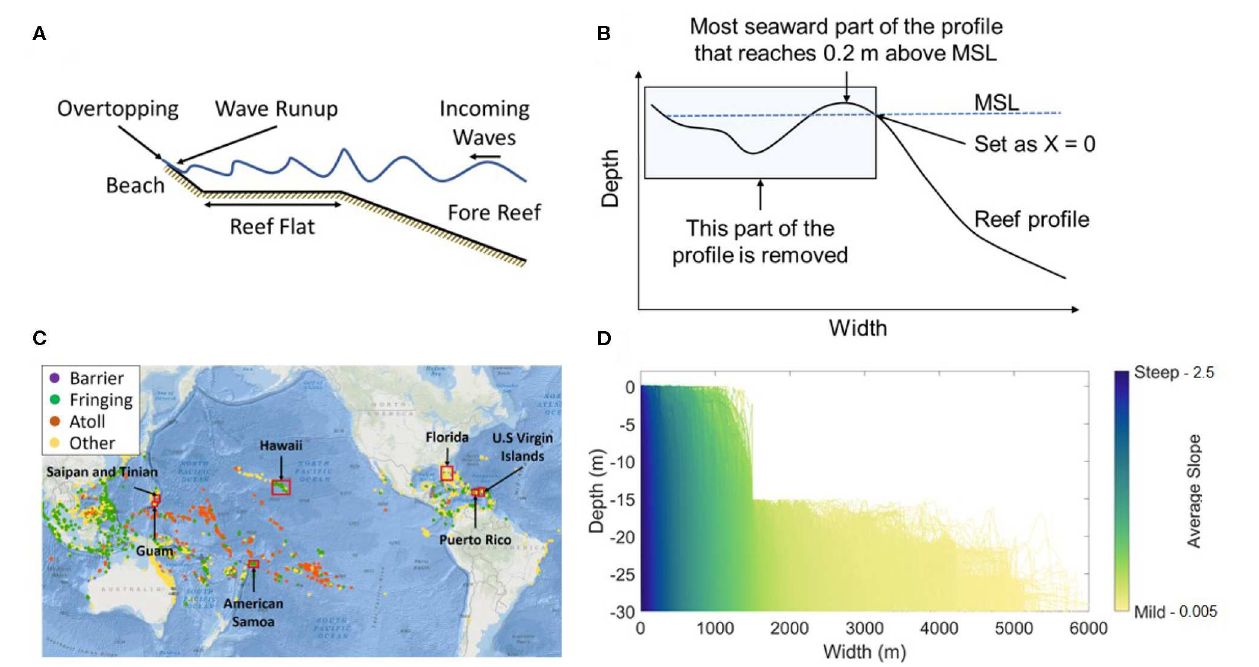
FIGURE 1 | Coral reef profile dataset information including (A) a schematic of a typical fringing reef demonstrating wave runup and overtopping from incoming waves, (B) an example of how the reference point (X = 0) was set at MSL for aligning the cross-shore profiles, (C) a map of the locations where the coral reef topobathymetric cross-shore profiles in the dataset have been collected (ReefBase, 2019; Storlazzi et al., 2019), and (D) the selected cross-shore profiles for the study plotted and colored based on their average slope which range from 0.005 to